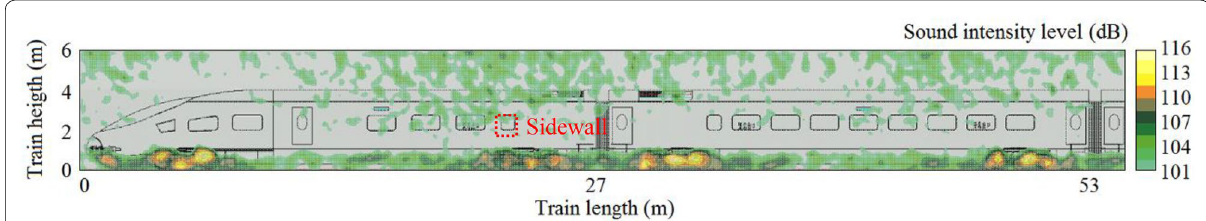
Figure 25 Measurement results for the exterior noise sources (500–5000 Hz, Linear weighted)